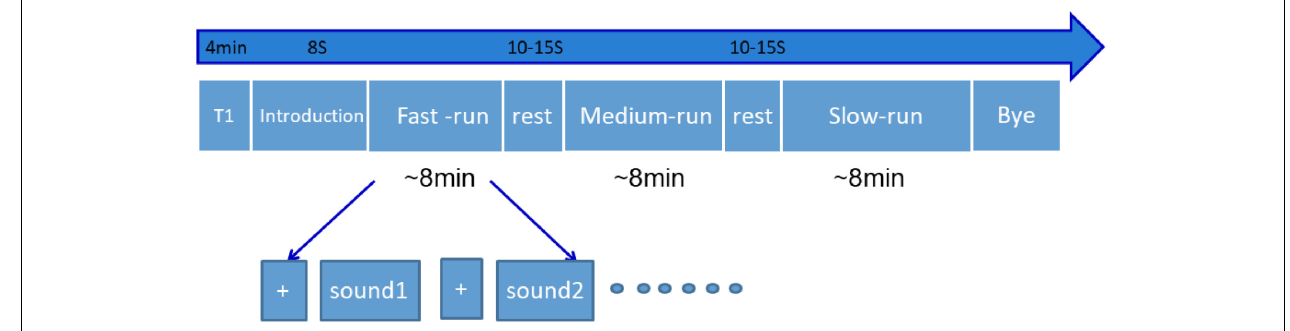
FIGURE 1 | The scanning procedure of the fMRI